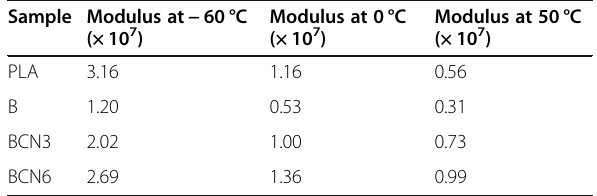
Table 4 The storage modulus of the prepared foams at different